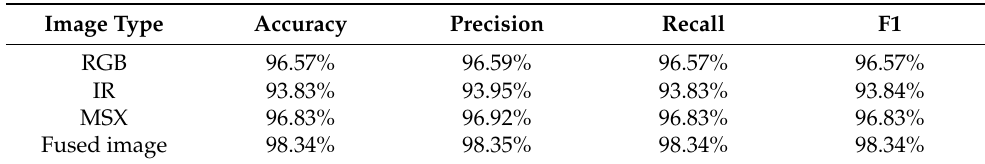
Table 4. Comparison of different input data in pavement crack